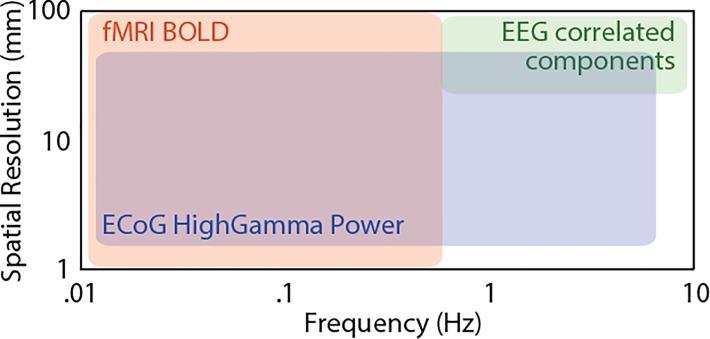
Spatiotemporal considerations.